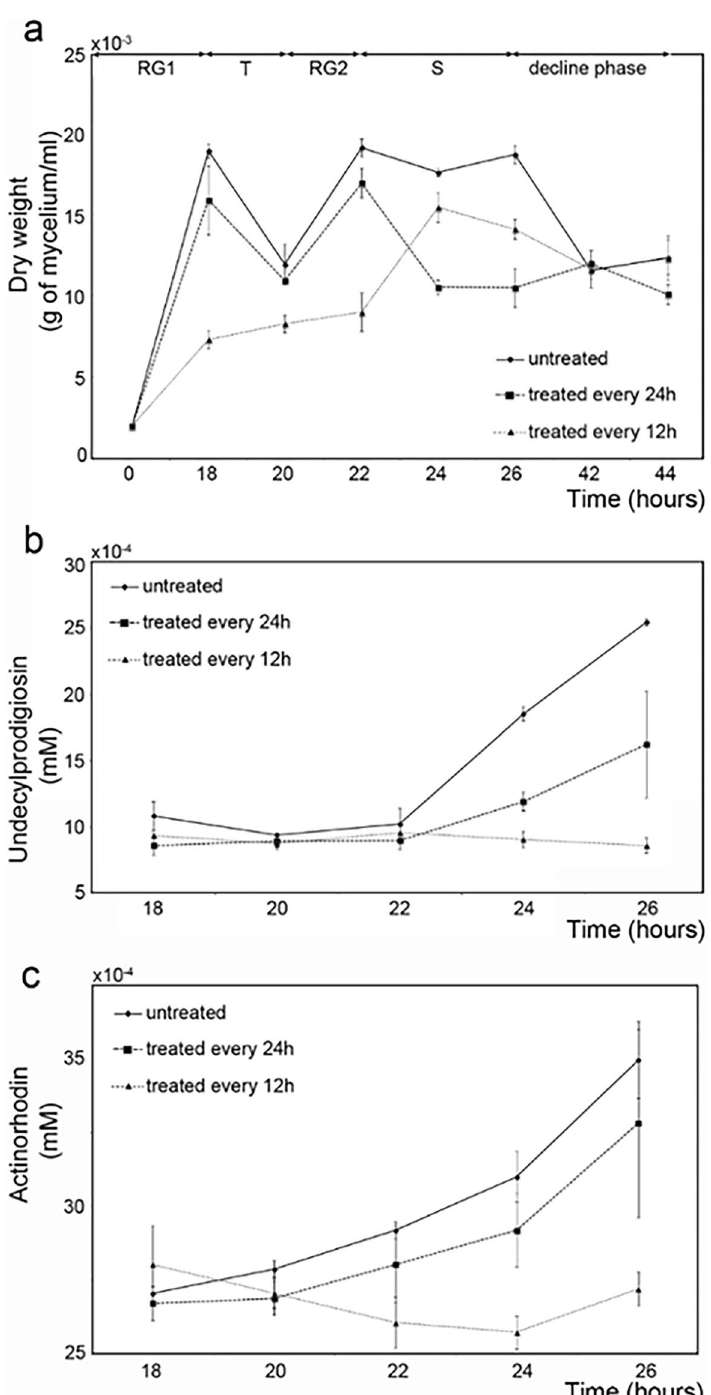
Figure 2. Growth curves ( a ) and quantitative analysis of undecylprodigiosin ( b ) and actinorhodin ( c ) of S. coelicolor M145 cultures untreated (indicated by circles) and treated with 5-aza-dC every either 12 (indicated by triangles) or 24 h (indicated by